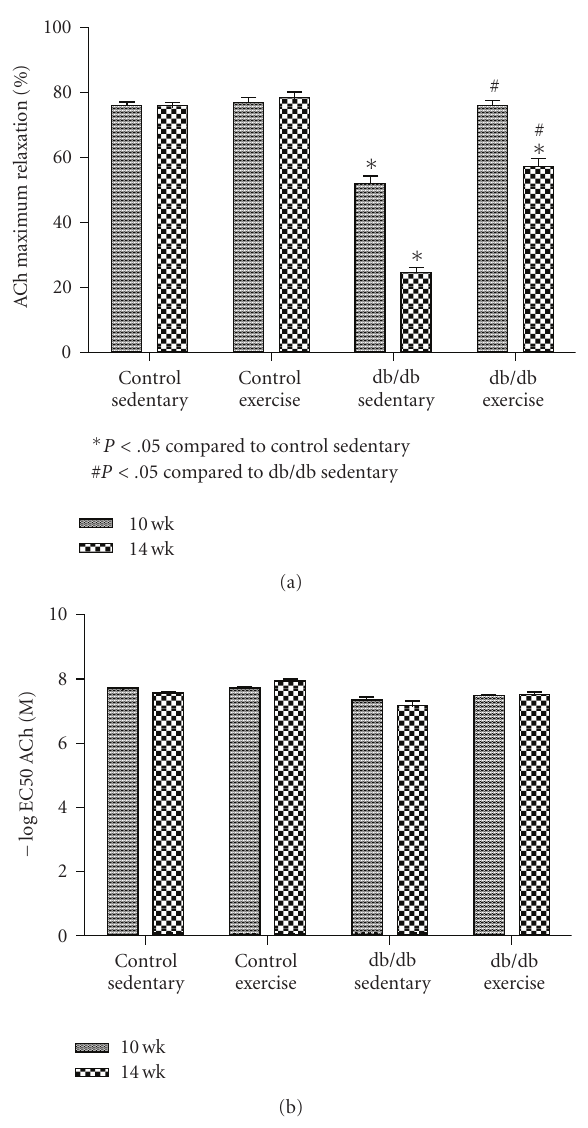
Figure 2: Emax (a) and EC50 (b) of ACh vasodilation after two weeks (10-week old mice) and six weeks (14-week old mice) of moderate-intensity